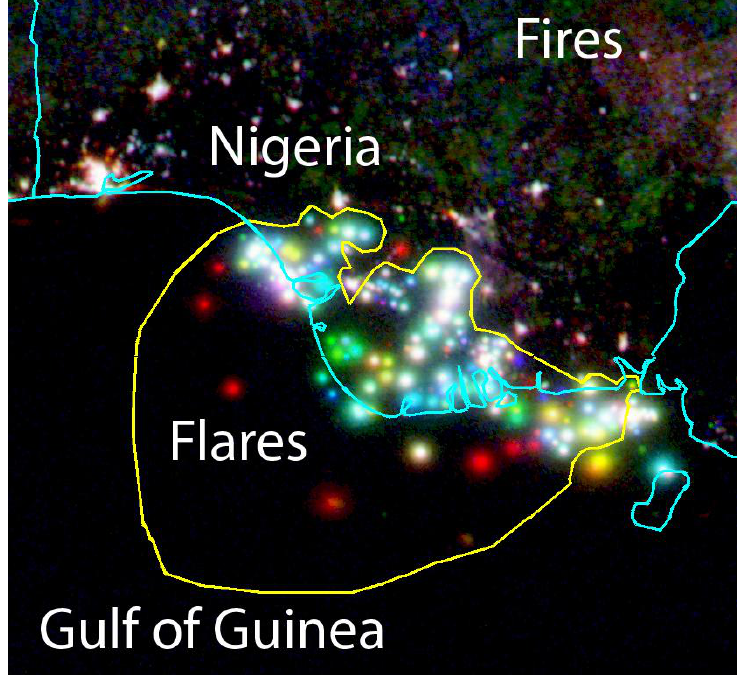
Figure 6. Color composite of the nighttime lights of the Nigeria region generated using 1994 as blue, 2000 as green, and 2008 as red. The colors of the flares indicate their activity patterns during the three years used in the color composite. Note the six red offshore flares, indicating the increase in offshore oil production in 2008 relative to 2000 and 1994. The vector polygon drawn around the gas flares of Nigeria is shown in yellow. The diffuse light in the upper right is from biomass